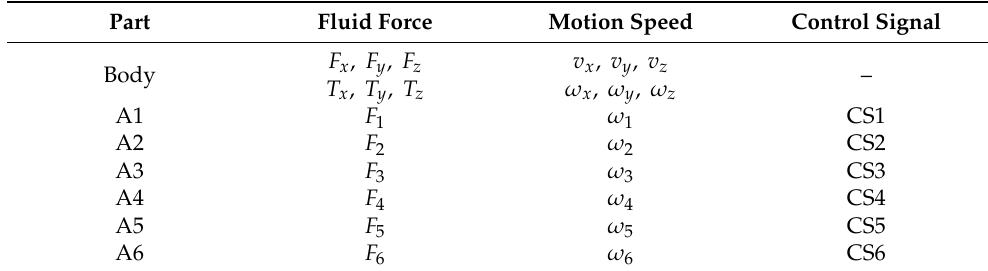
Table 1. Fluid Force, Motion Speed and Control Signal for Each Part of UVMS. Part